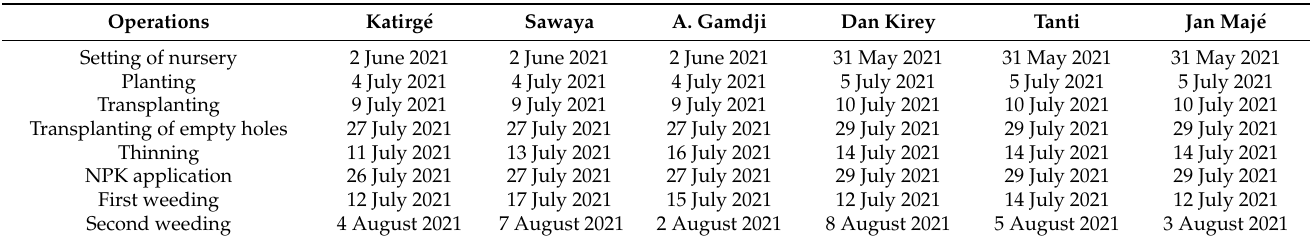
Figure 3. Transplanted field ( A ) and harvested field ( B ) at the village of Katirgé. Table 1. Cropping operations calendar.